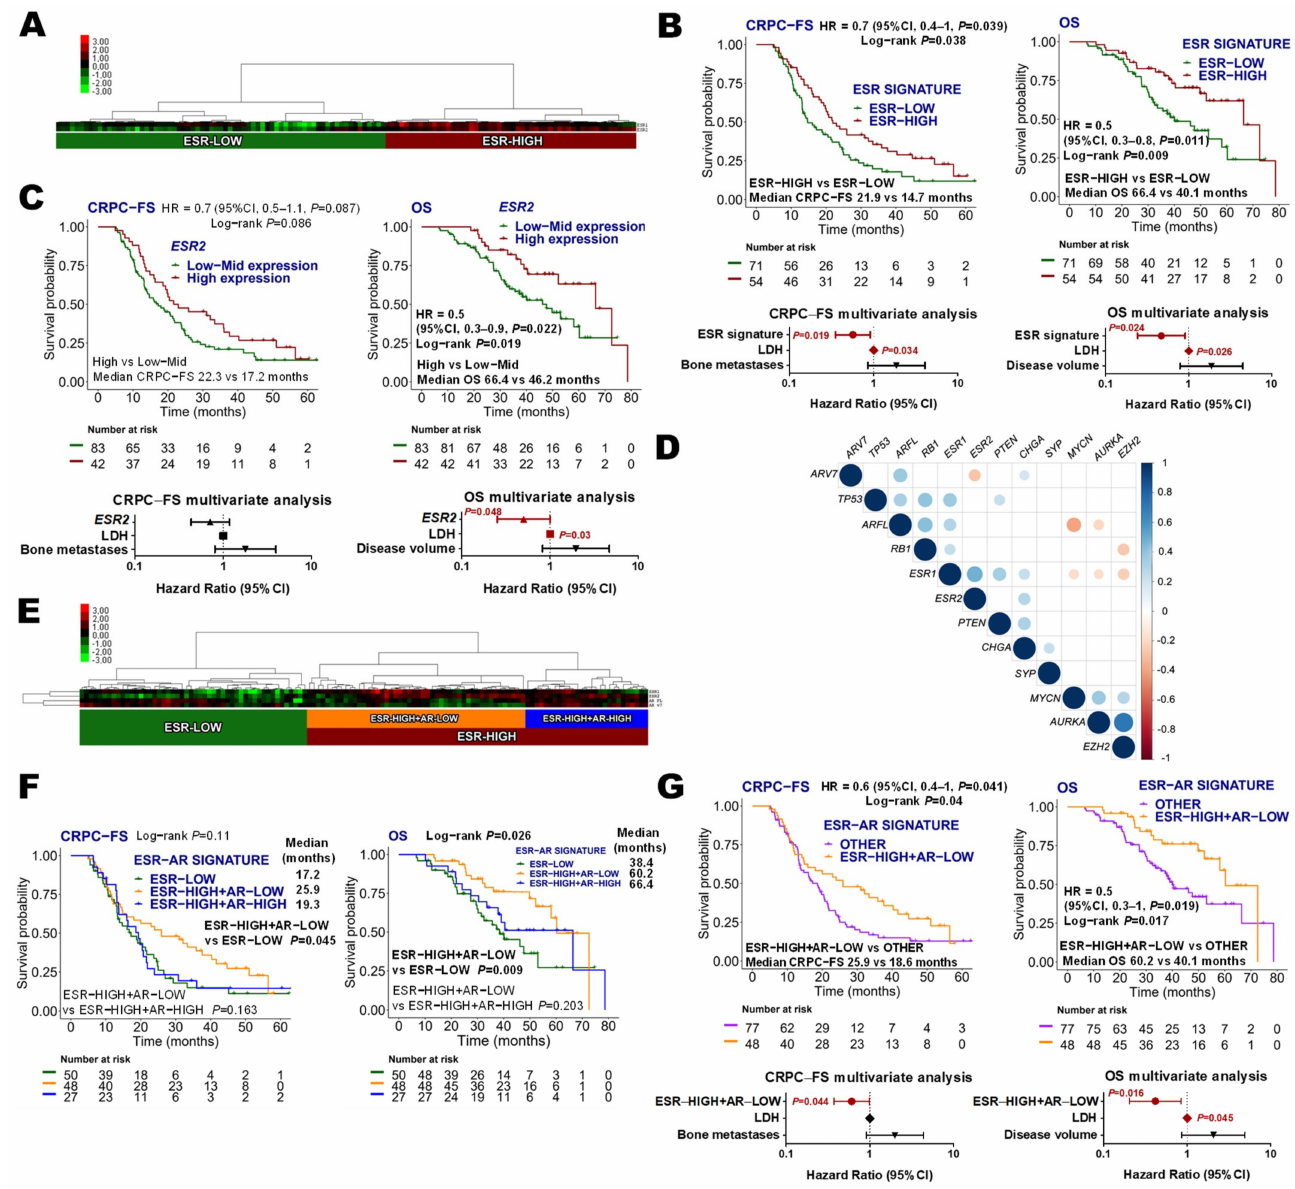
Figure 3. Estrogen receptor (ESR) signature. ( A ) Hierarchical clustering expression heatmap for expression values of the ESR signature; ( B ) Kaplan–Meier curves representing CRPC-free survival (CRPC-FS) and overall survival (OS) according to ESR signature and forest plots representing the multivariate analysis; ( C ) Kaplan–Meier curves representing CRPC-FS and OS according to ESR2 expression segregated into tertiles and forest plots representing the multivariate analysis; ( D ) cor- relation matrix of ESR , AR , neuroendocrine ( AURKA , CHGA , SYP , MYCN , and EZH2 ) and tumor suppressor ( TP53 , RB1 and PTEN ) genes. Correlation coefficients (r) between expression values are represented when p < 0.05; ( E ) hierarchical clustering expression heatmap for expression values of the ESR and AR genes; ( F ) Kaplan–Meier curves representing CRPC-FS and OS according to ESR and AR genes; ( G ) Kaplan–Meier curves representing CRPC-FS and OS according to ESR-High+AR-low and the other groups and forest plots representing the multivariate analysis. LDH: lactate dehydrogenase; HR: hazard ratio; CI, confidence